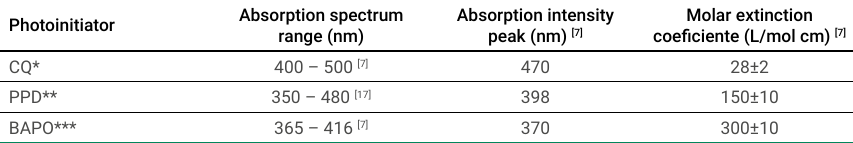
Table 1. Characteristics of photoinitiators used in this study.